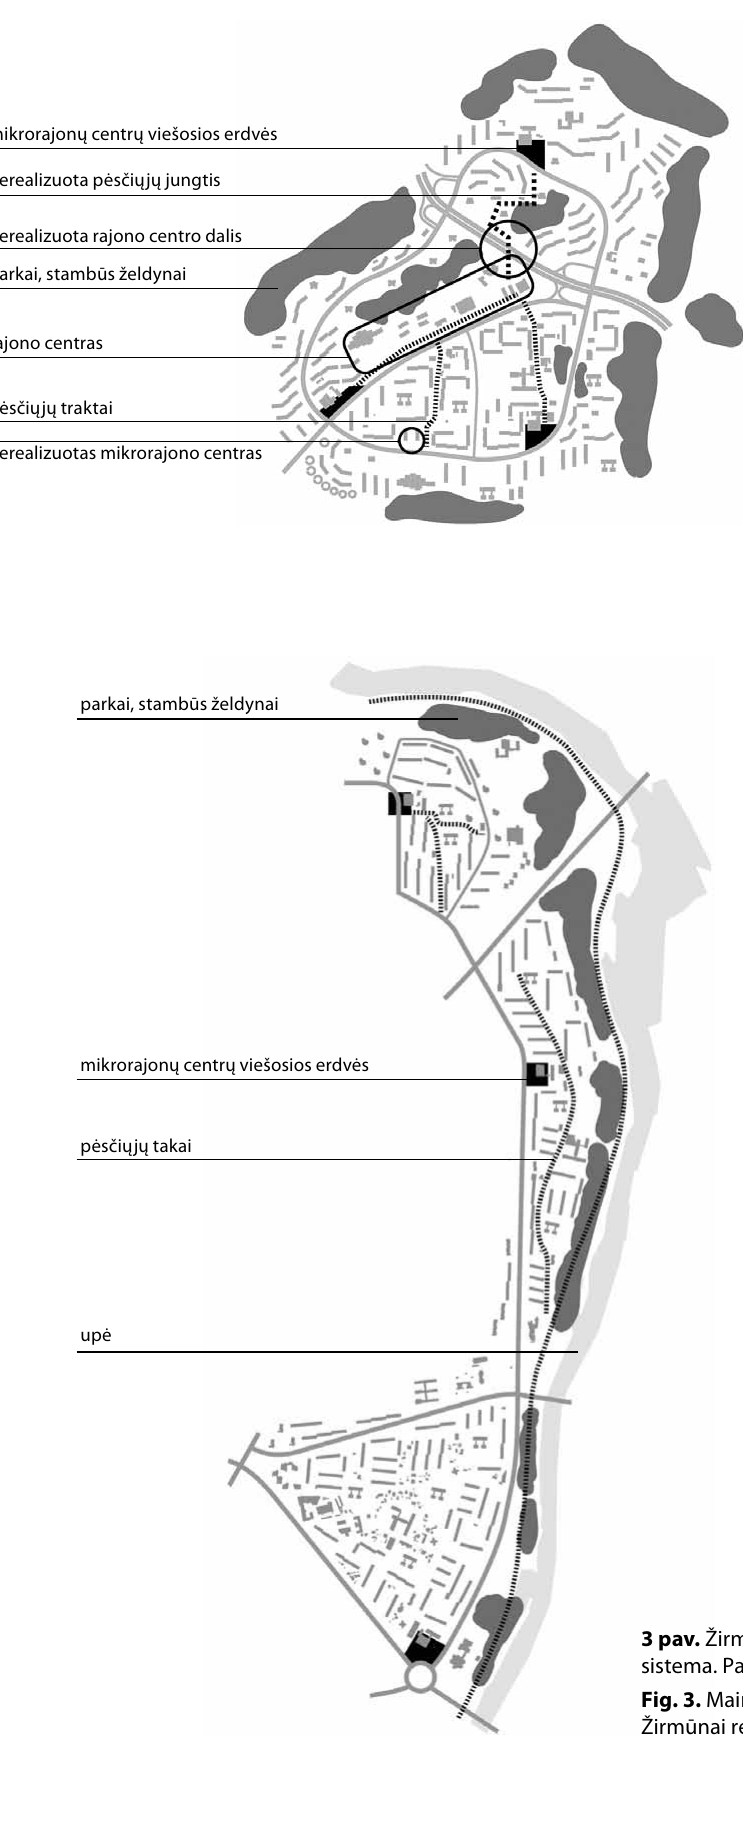
Fig. 3. Main elements of Public Space system